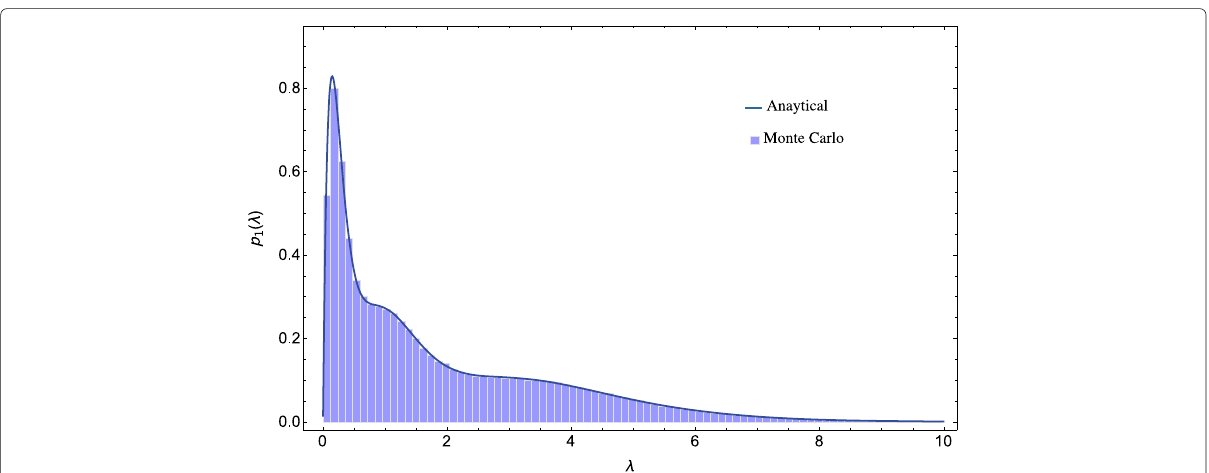
Fig. 2 Marginal density of eigenvalues of the quotient ensemble. The parameters used are n = 3, n A = 4, n B = 5, a = 1, and b = 1 /